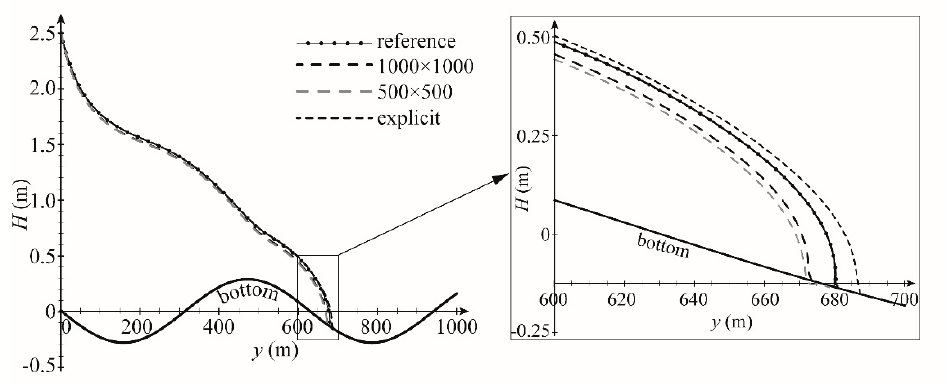
Figure 10. Water profiles along the row corresponding to x = 500 m computed at the time 1200 s using the explicit and implicit schemes for grid resolutions 1000 × 1000 and 500 × 500.